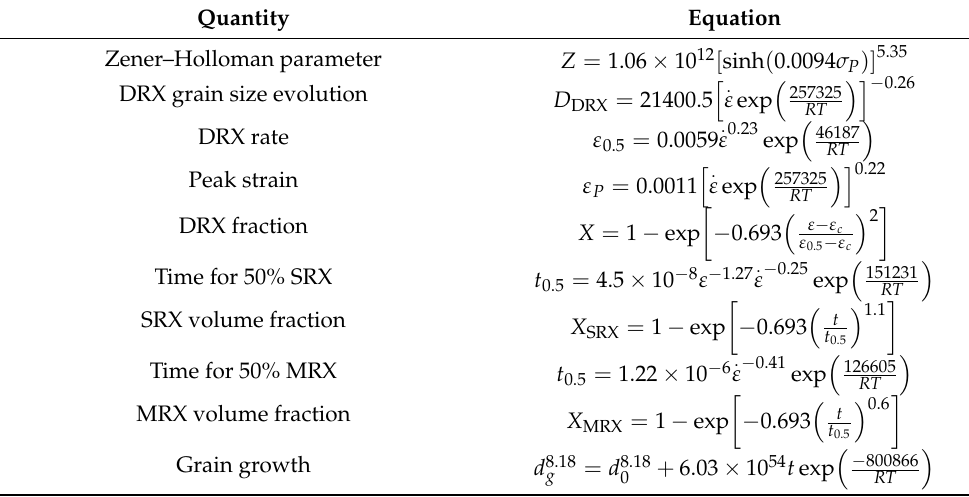
Table 2. Microstructural evolution model of SDP1 steel.